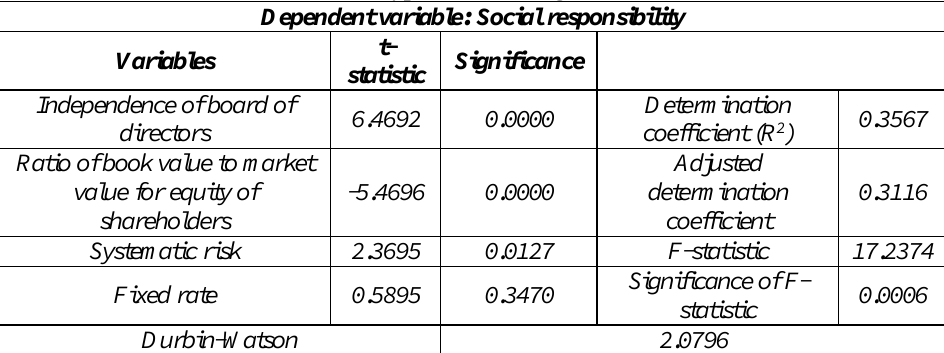
Table 6. The findings of approximation of regressive model related to the second